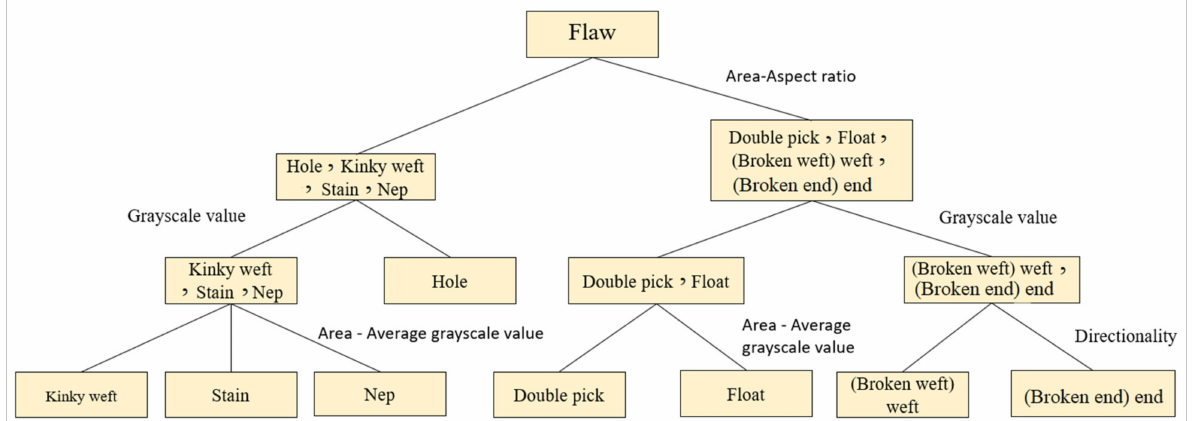
Figure 15. Defect classification